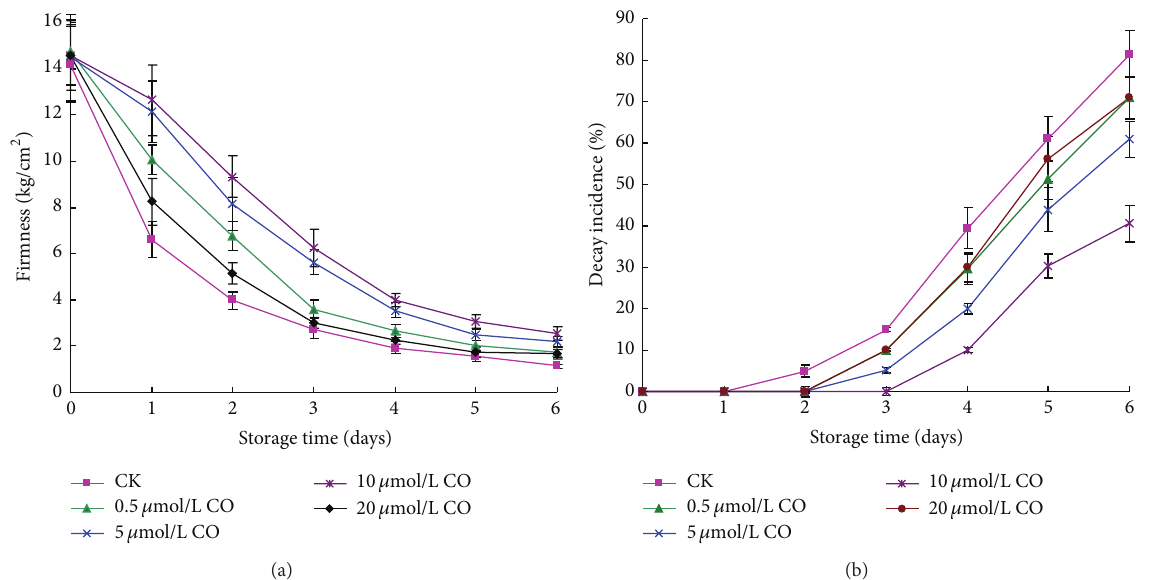
Figure 1: Effect of CO fumigation on the firmness (a) and decay incidence (b) of postharvest peaches. Each point represents the mean value ± SD.